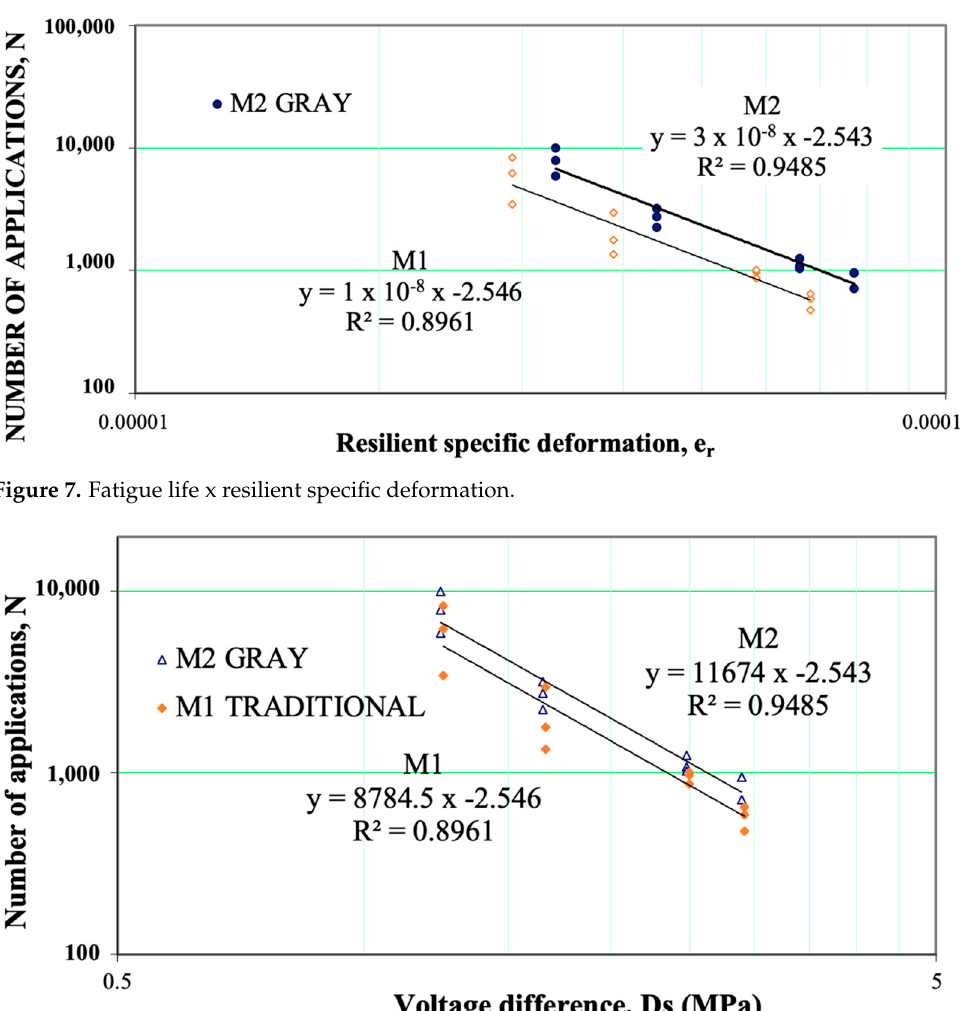
Table 7. Regression parameters of the fatigue life curves of the mixtures.